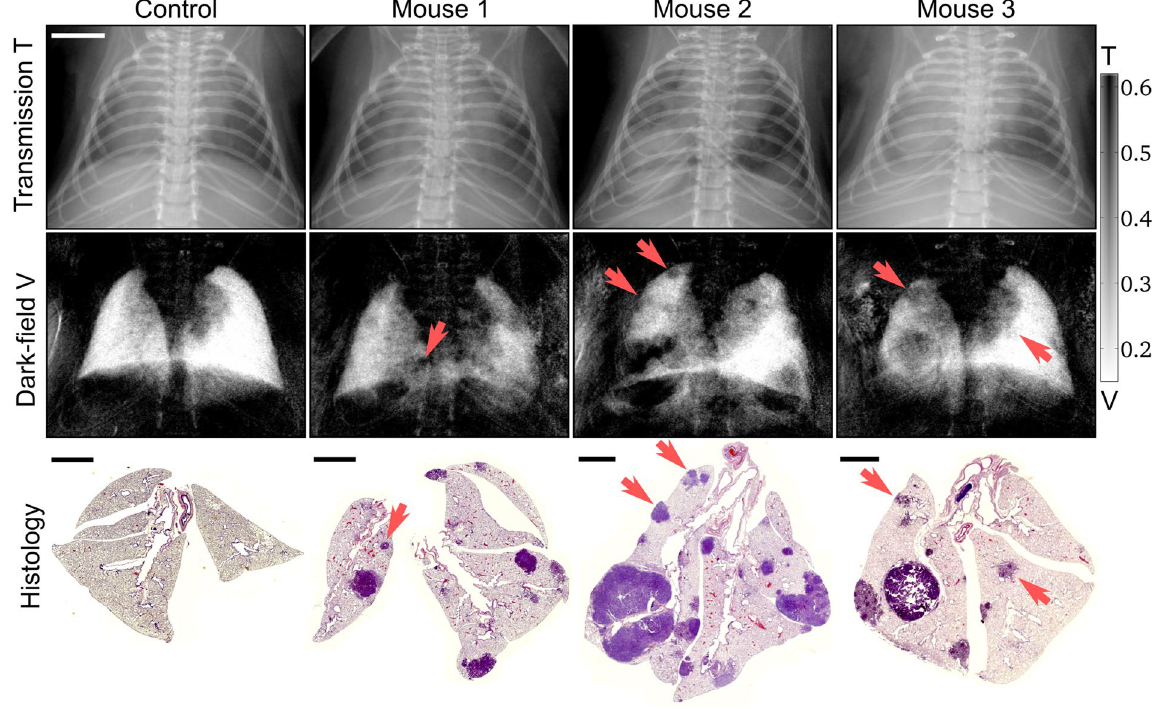
Figure 2. Qualitative benchmark of in-vivo transmission versus dark-field radiography for the assessment of lung nodules. Typical transmission and dark-field radiograms of a control mouse and three mice with lung tumors, alongside with the corresponding histological sections in H&E staining. Small nodules are much easier to detect within the dark-field image (red arrows) than in the attenuation channel, due to a minor impact of overlaying structures and the overall dominant scatter signal of the lung within the thorax. The scale bars correspond to 5 mm and 2.5 mm on the radiograms and histological sections, respectively. The color-scale corresponds to the linear signal of both dark-field and transmission